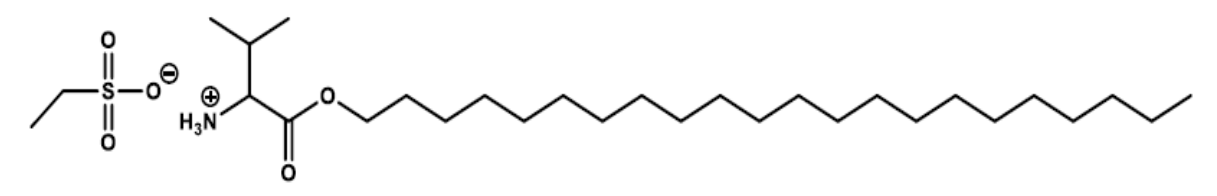
Figure 1. Brassicyl Valinate Esylate (BVE).